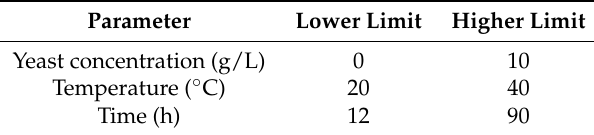
Table 2. Range of input parameters for LHS design.